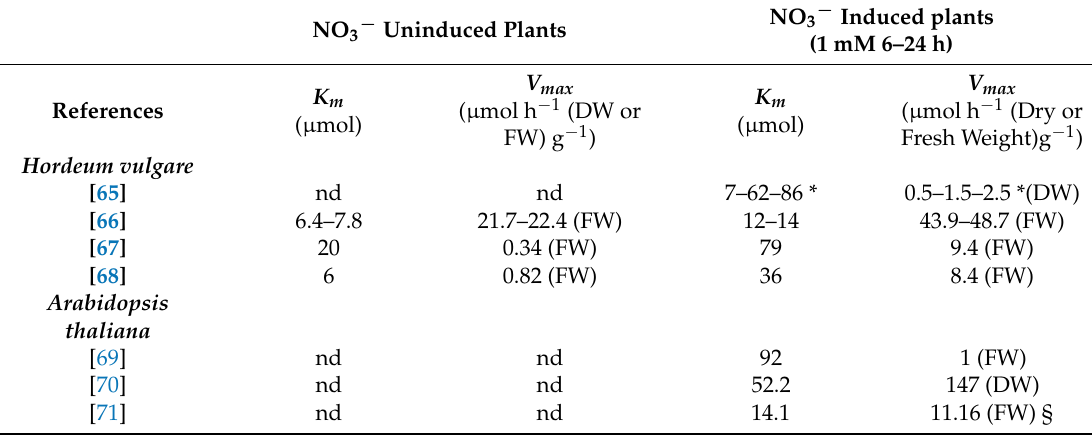
Table 2. Michaelis–Menten half-saturation constants and maximum velocity for nitrate uptake from publications in barley ( Hordeum vulgare ) and Arabidopsis thaliana